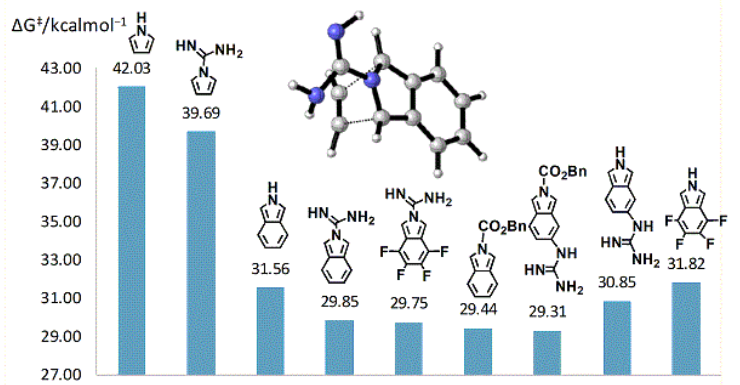
Figure 3. Activation-free energies of the Diels–Alder reaction of pyrrole and isoindoles with acety- lene and optimized transition state structure of the reaction with isoindole-2-carboxamidine as calculated by M062X/6-311+G**.